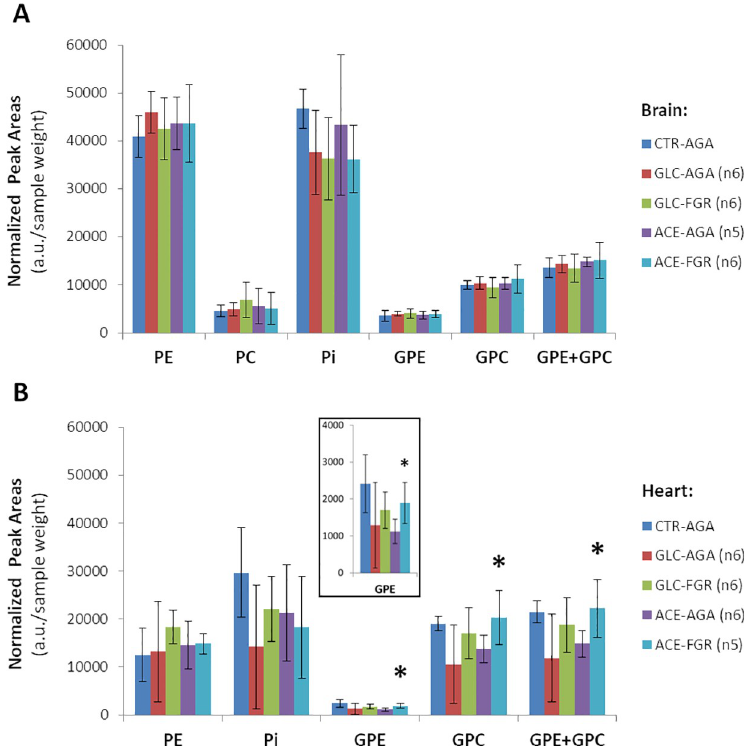
Fig 6. Quantification of phosphorylated metabolites based on 31 P spectra for different tissue samples and experimental groups. Values displayed as metabolite peak areas normalized to sample weight (average ± SD) for brain ( A ) and heart ( B ) samples of CTR, GLC and ACE groups. PC could not be quantified properly in heart samples due to overlap with 2,3-diphosphoglycerate (Fig 5). Significant differences between AGA and FGR subjects are indicated ( � p < 0.05, two-tailed unpaired